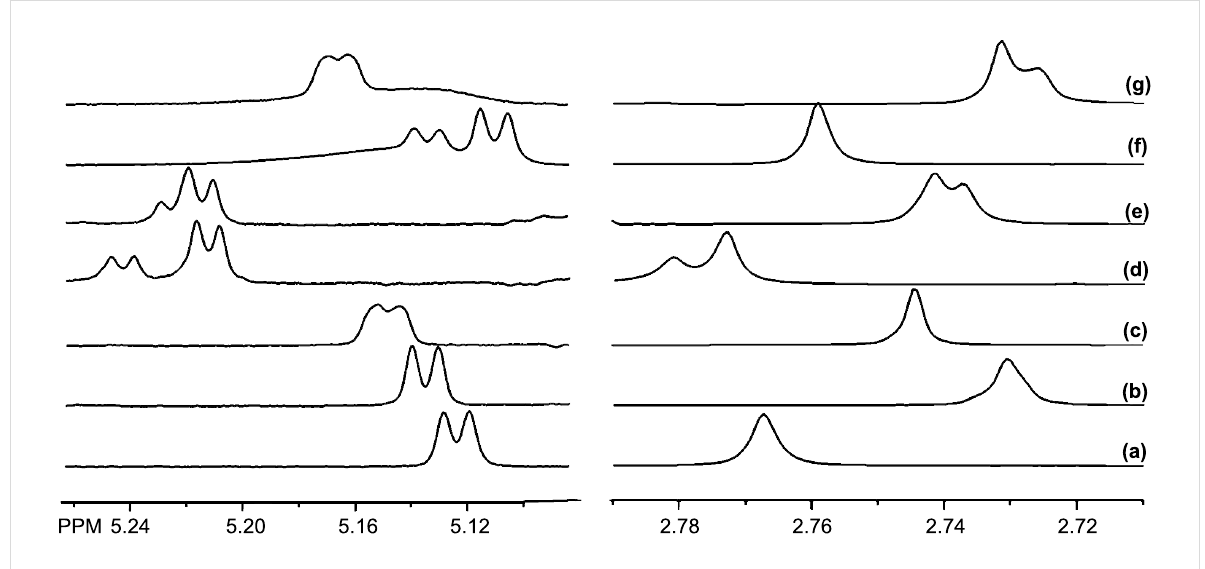
Figure 4: The (a) methine resonance of the carbinol carbon (5.124 ppm) and N -methyl resonance (2.768 ppm) of 7 (10 mM, enriched in (1 S ,2 R )-en- antiomer) with 20 mM of (b) P- α -CD-L DS , (c) P- α -CD-H DS , (d) P- β -CD-L DS , (e) P- β -CD-H DS , (f) P- γ -CD-L DS and (g) P- γ -CD-H DS .